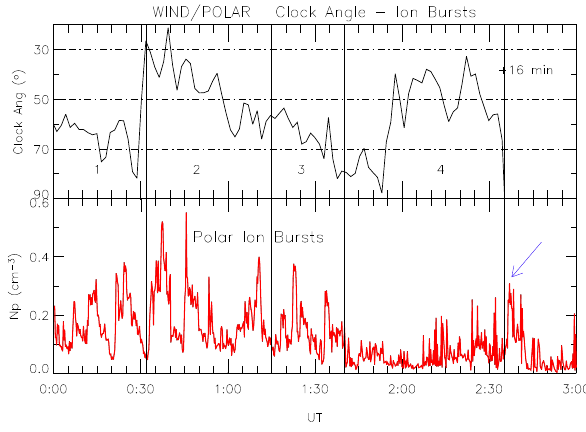
Fig. 8. Top panel: Clock angle at Wind shifted forward by 16min, our estimated Wind-Polar propagation delay. Bottom: Polar den- sities corresponding to the ion bursts. Numbered subintervals are delimited by vertical